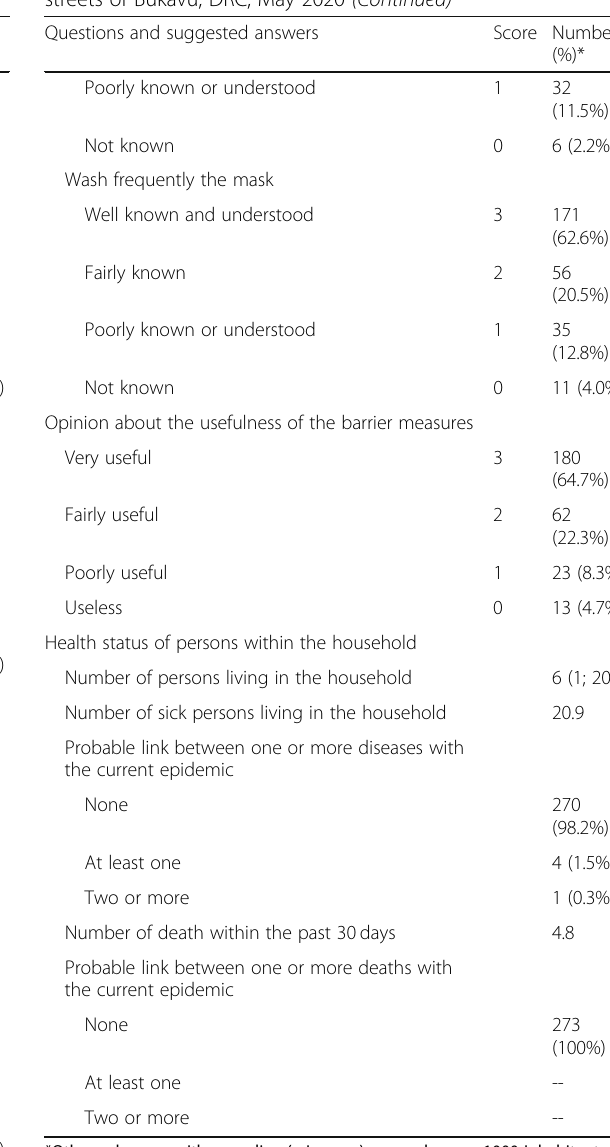
Table 1 Content of the questionnaire given to passers-by in the streets of Bukavu, DRC, May 2020